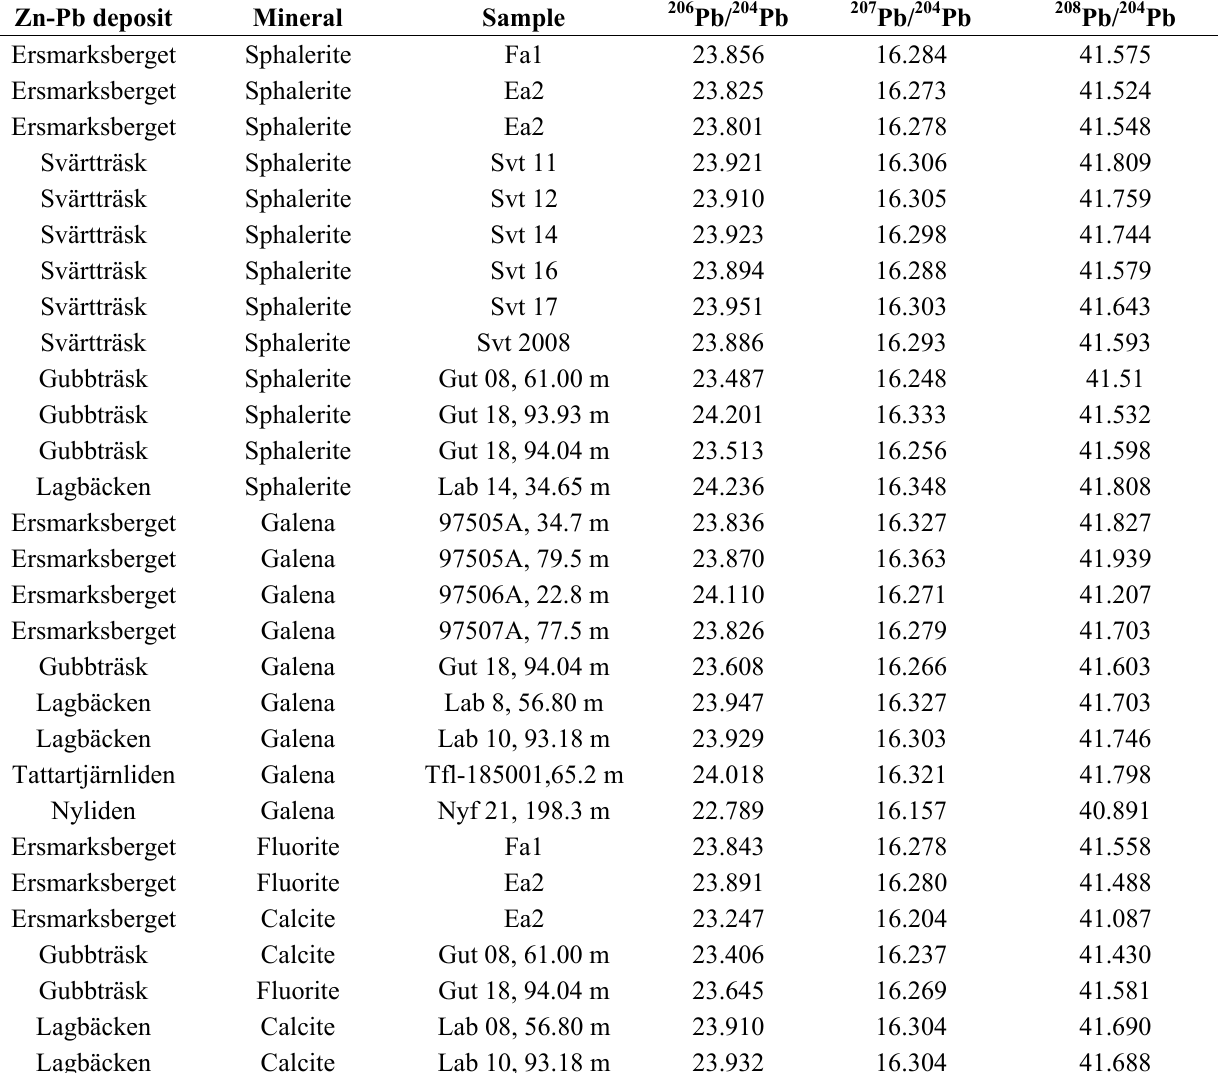
Table 2. Pb data obtained for the residual fraction of treated sphalerite, galena and gangue minerals. Zn-Pb deposit